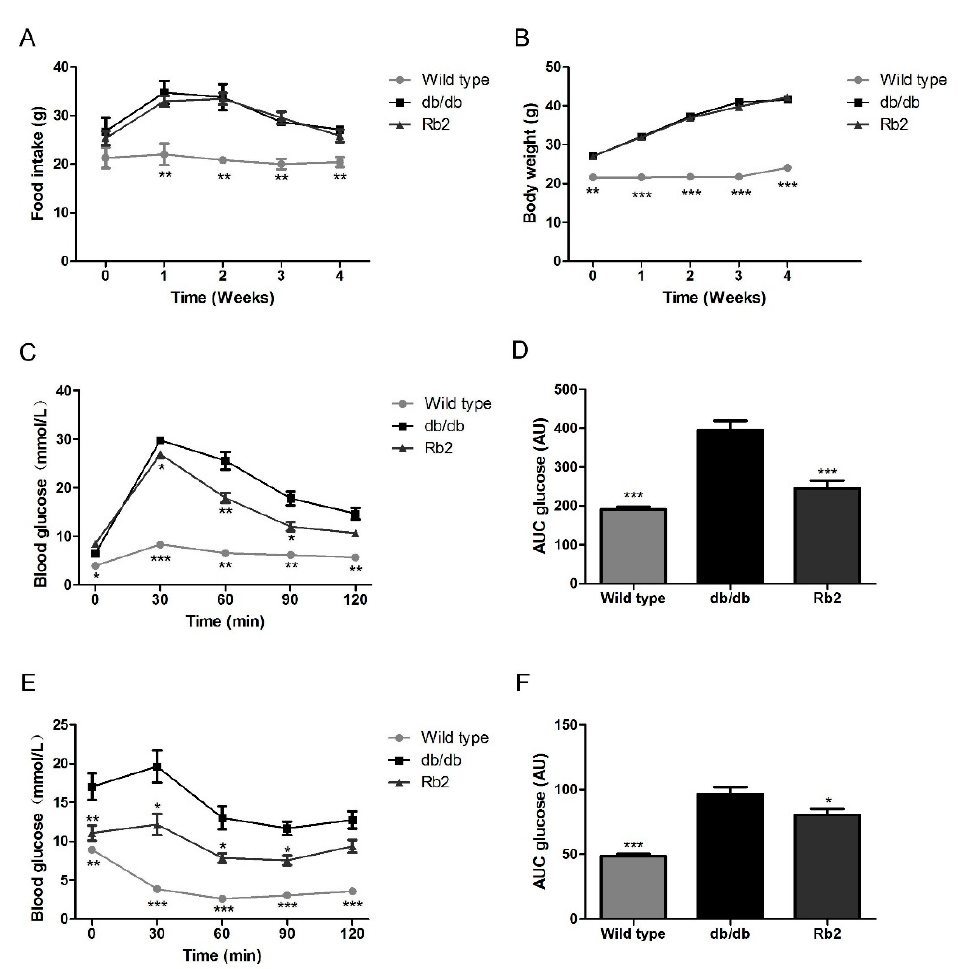
Figure 1. Metabolic effects of Rb2 on db/db mice. The alteration of food intake ( A ) and body weight ( B ) in 6-week-old db/db mice and wild type mice were monitored during the 4-week administration. db/db mice in two different groups were treated with either Rb2 (10 mg/kg) or saline. At day 21, the glucose tolerance test was performed after an oral administration of glucose (1 g/kg body weight, C , D ). At day 24, the insulin tolerance test was performed after intraperitoneal injection of insulin (0.8 IU/kg body weight, E , F ). The tail vein blood was collected and glucose concentrations were measured at 0, 30, 60, 90, and 120 min. Wild type: Wild type mice as normal control, db/db: Vehicle-treated db/db mice, Rb2: Rb2 (10 mg/kg body weight)-treated db/db mice. Data are expressed as mean ± standard error (SE) from 10 animals per group. * p < 0.05, ** p < 0.01, and *** p < 0.001 compared with vehicle-treated db/db mice group. AU, any unit. AUC, area under the curve, the basal glucose values of each mouse in oral administration of glucose (OGTT) and intraperitoneal insulin tolerance test (IPITT) AUC is set to 1.